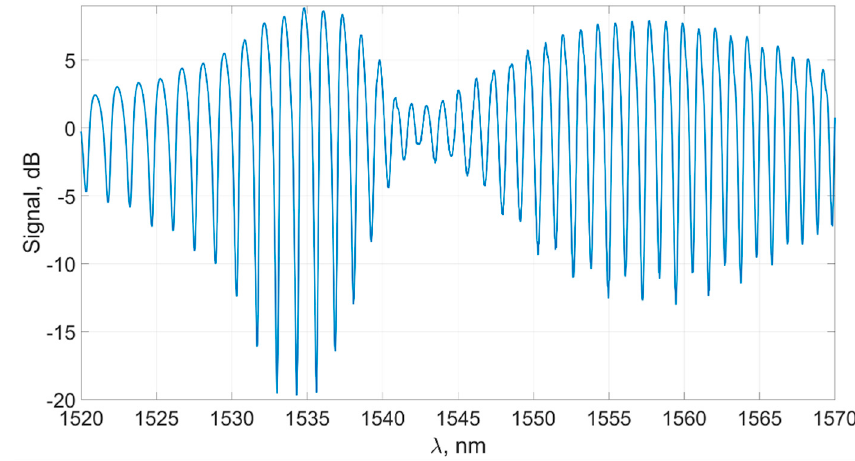
Figure 8. Sensor signal after alignment with the horizontal axis.